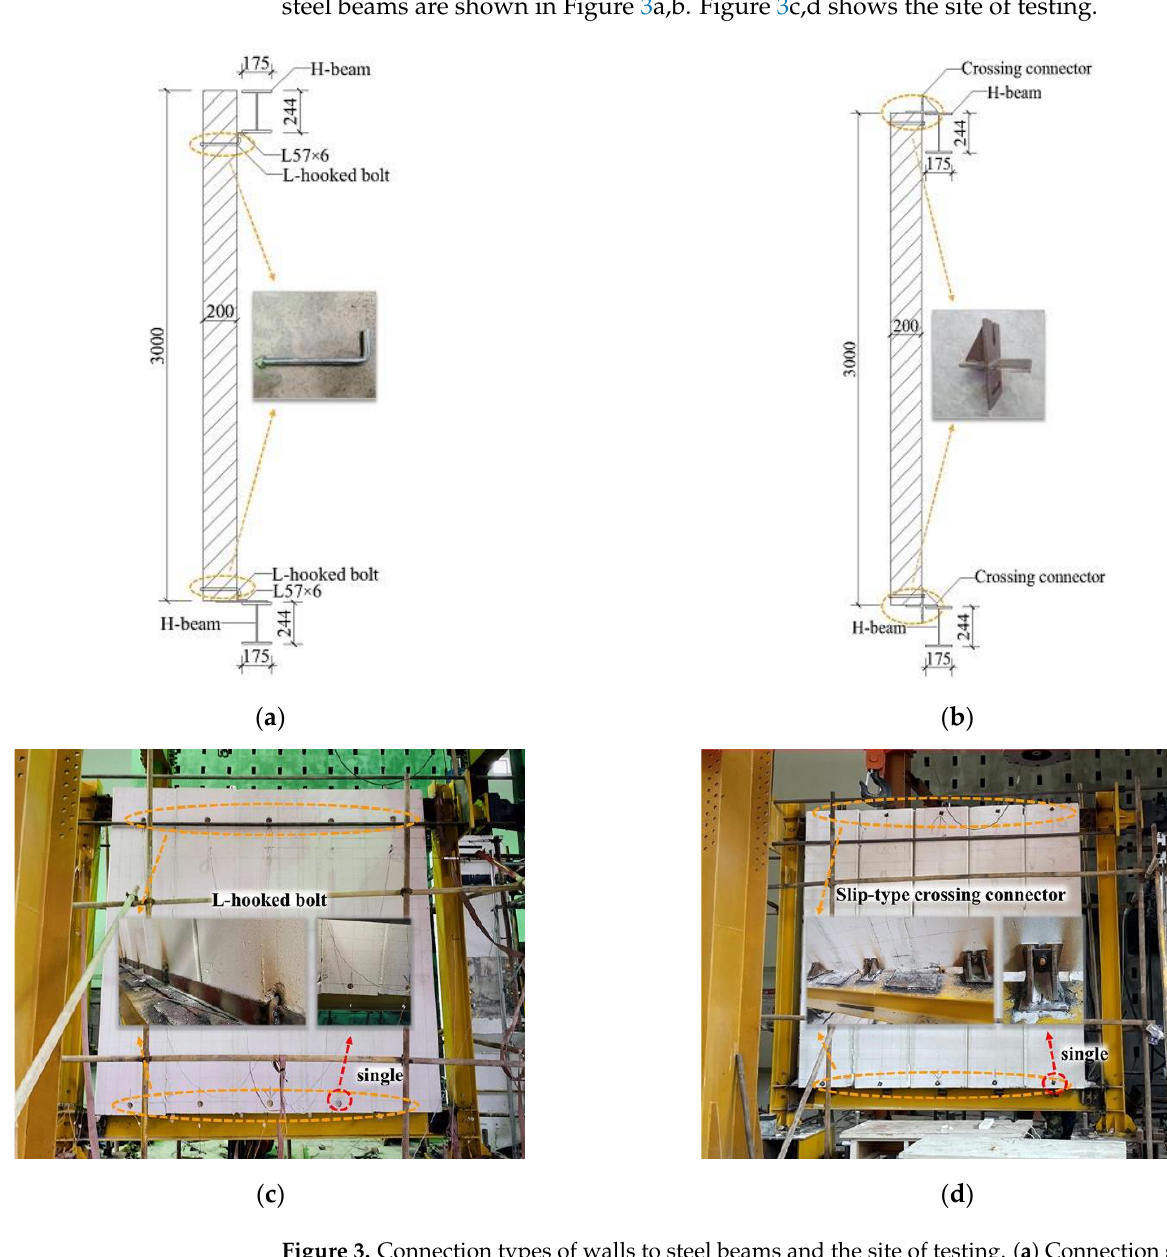
Figure 3. Connection types of walls to steel beams and the site of testing. ( a ) Connection schematic diagram of L-hooked bolt; ( b ) connection schematic diagram of crossing connector; ( c ) specimen JD-1; ( d ) specimen JD-2.